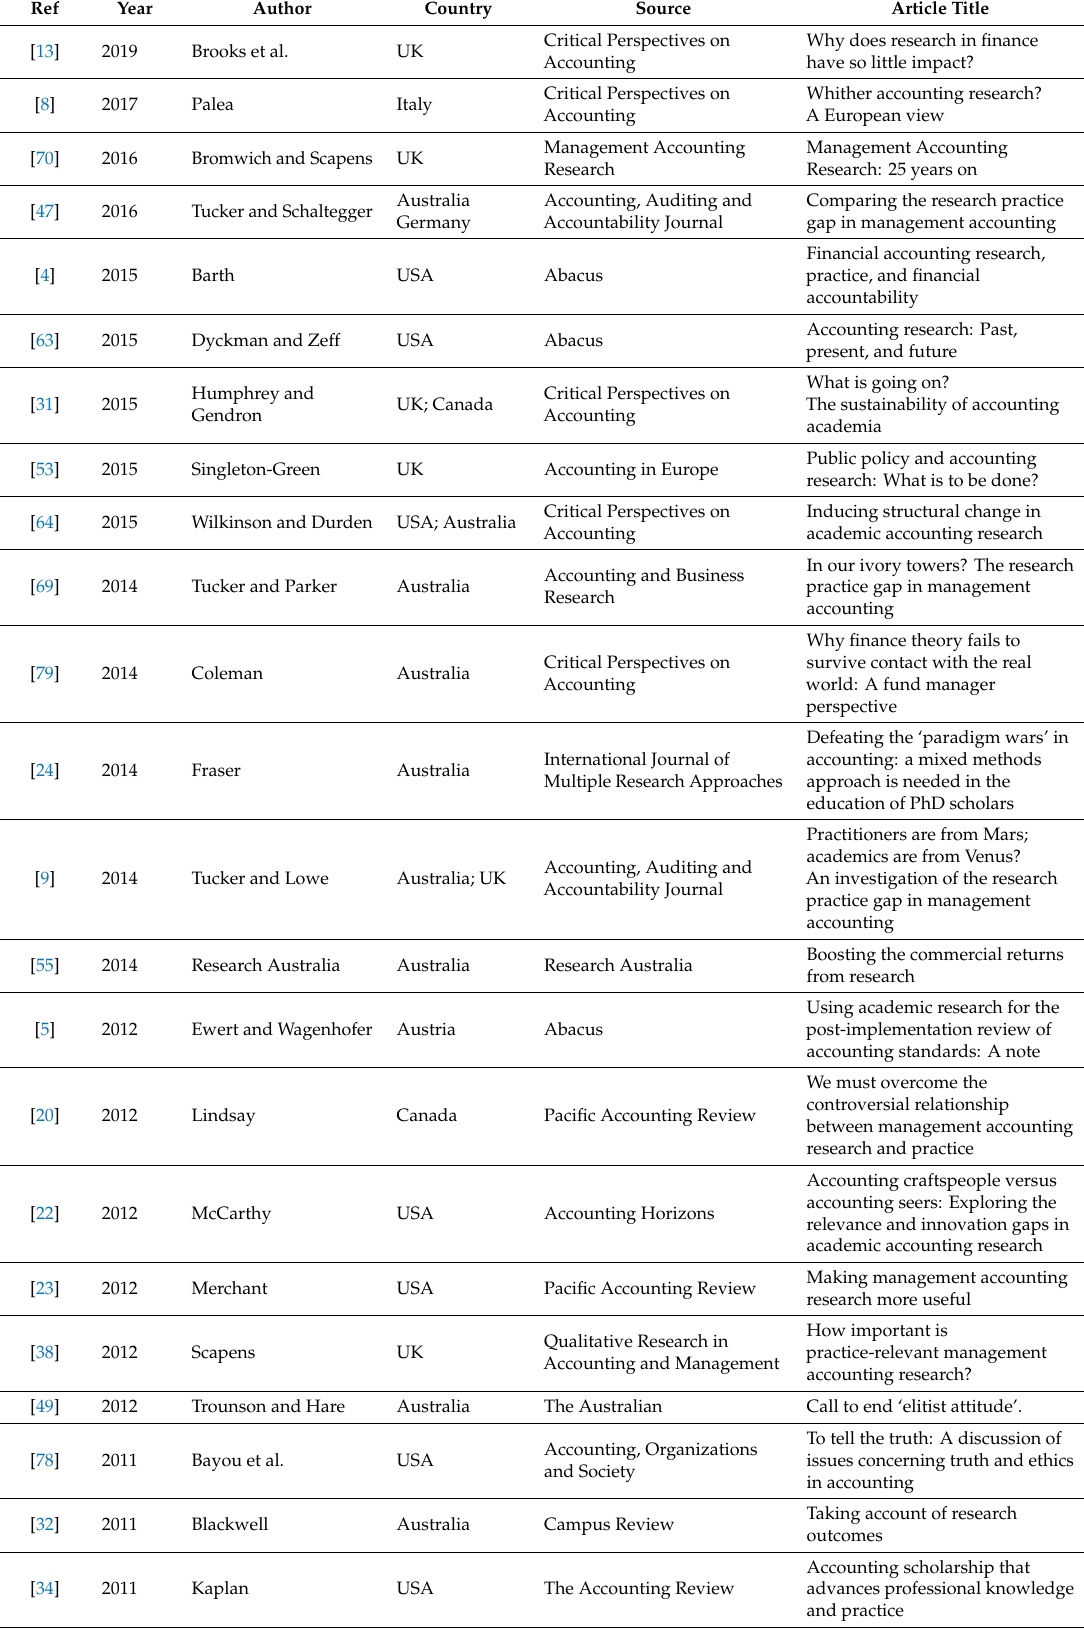
Table 1. Summary of accounting articles highlighting the research practice